Question: Provide a one-line summary of what is displayed.
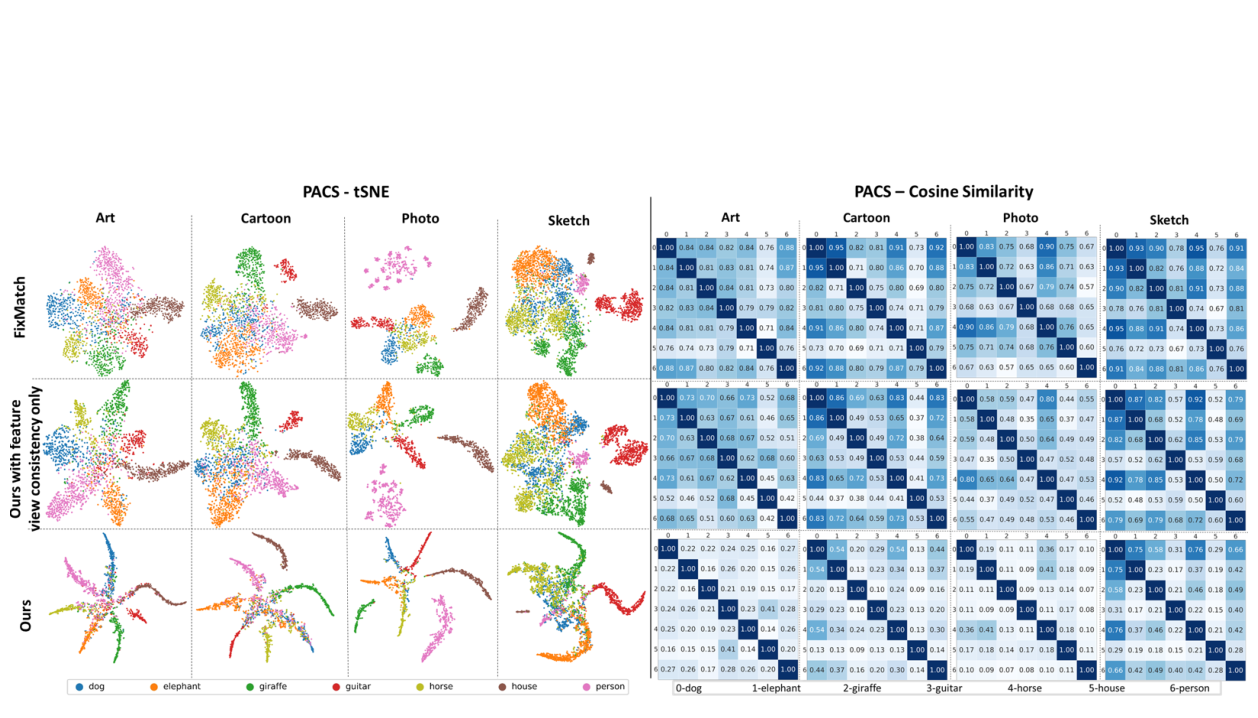
Answer: We visualize the feature space using tSNE (left), and the cosine similarity between the means of class-wise features (right) for PACS test domains of baseline (first row), ours with feature-based conformity only (second row), and ours with both feature-based conformity and semantic alignment loss (third row).